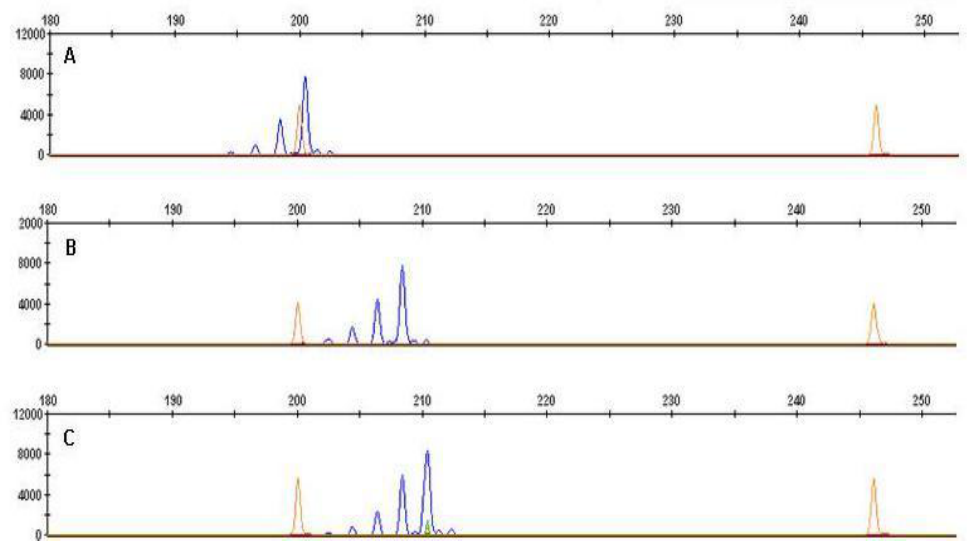
Figure 1. Microsatellite (SSR) products amplified by primer Xgwm 190 for wheat lines: ( A ) CHD 169/04 (200 bp), ( B ) CHD 760/4 (208 bp) and ( C ) CHD 65/04 (210